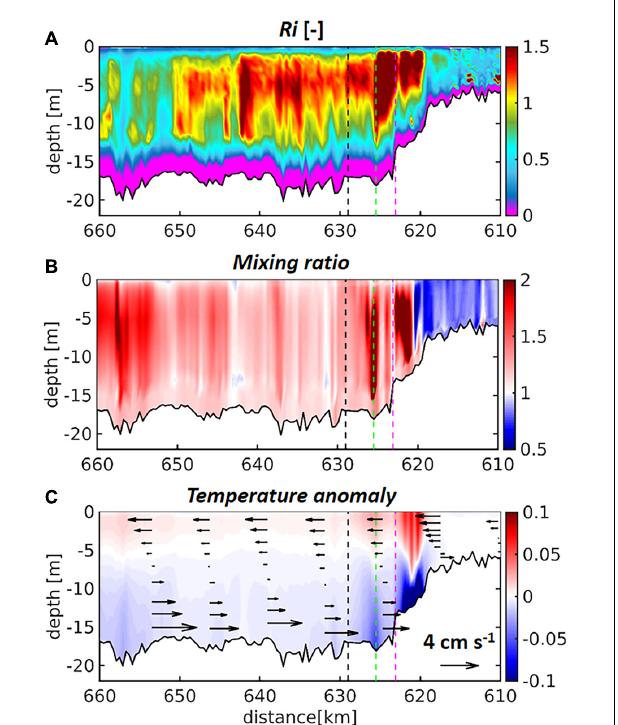
FIGURE 4 | Taylor diagram representing the normalised standard deviation, the correlation coefficient, and the root mean squared error of (A) simulated surface temperature against respective observations at several stations along the main estuarine channel. In (A) , the grey dots represent locations between km 725 and km 609. In (B) the shaded area illustrates the along-channel depth distribution and the grey dots represent the observed near-shore surface water temperature between May and September 2012. The black and blue dashed lines mark the stations Seemannshöft and Cuxhaven, respectively; see labels “HH” and “CUX” in Figure 1 .